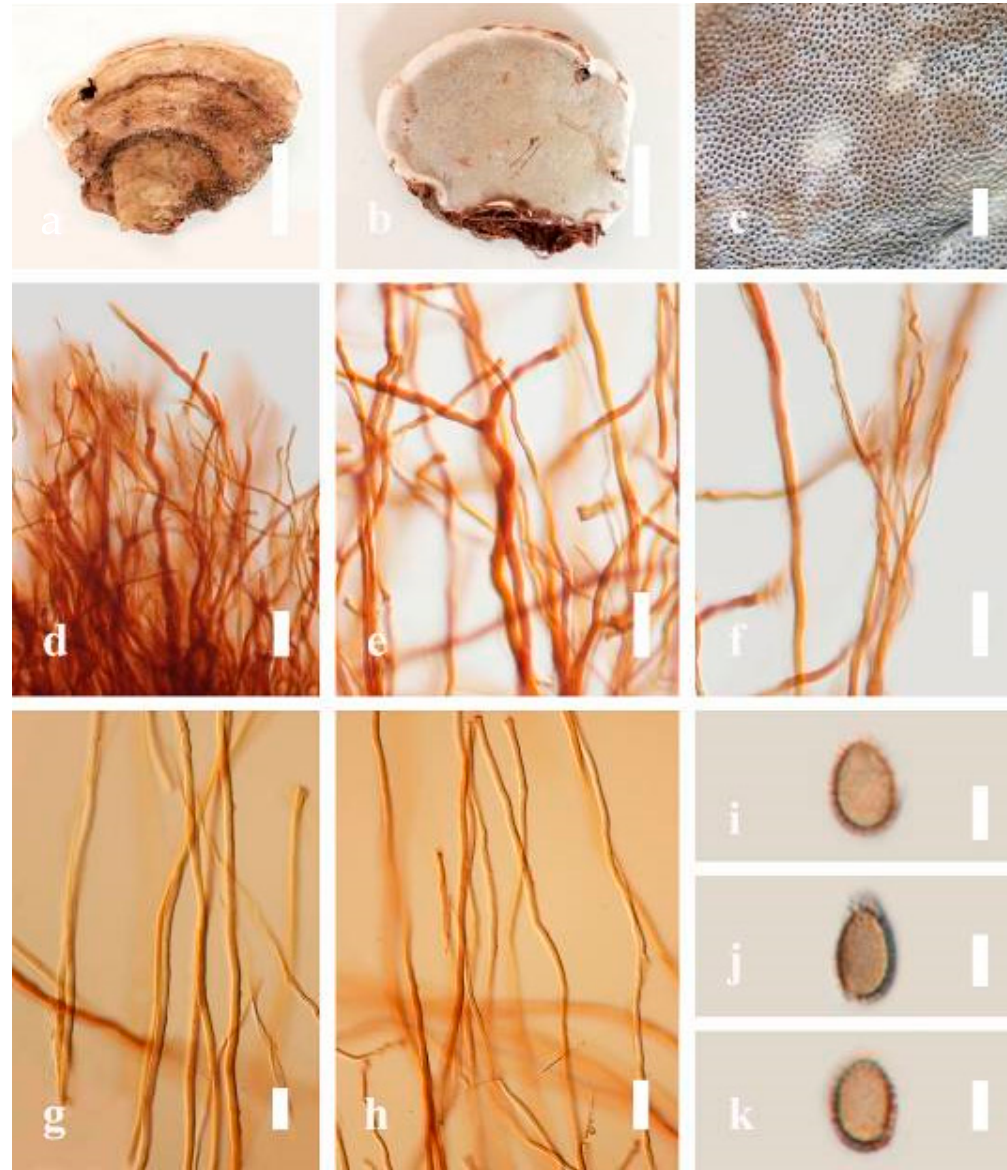
Figure 4. Morphology of Ganoderma applanatum (HKAS 107254, MFLU 19 ‐ 2188): ( a , b ) mature basidiomes; ( c ) pore characteristics; ( d – f ) hyphae of trama in KOH; ( g , h ) generative hyphae of context in KOH; ( i – k ) basidiospores. Scale bars: ( a , b ) = 2 cm, ( c ) = 1000 μ m, ( d – h ) = 20 μ m, ( i – k ) = 5 μ m.